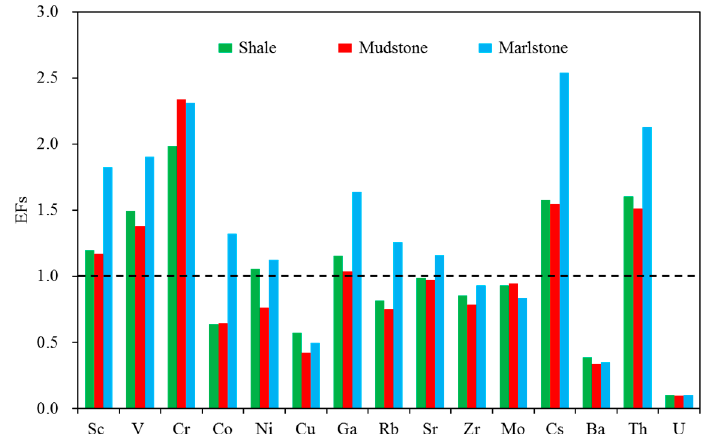
Figure 5. EFs diagram of the selected trace elements in the Datang Formation black rock series. A horizontal line (EF = 1) highlighting an element enrichment or depletion.